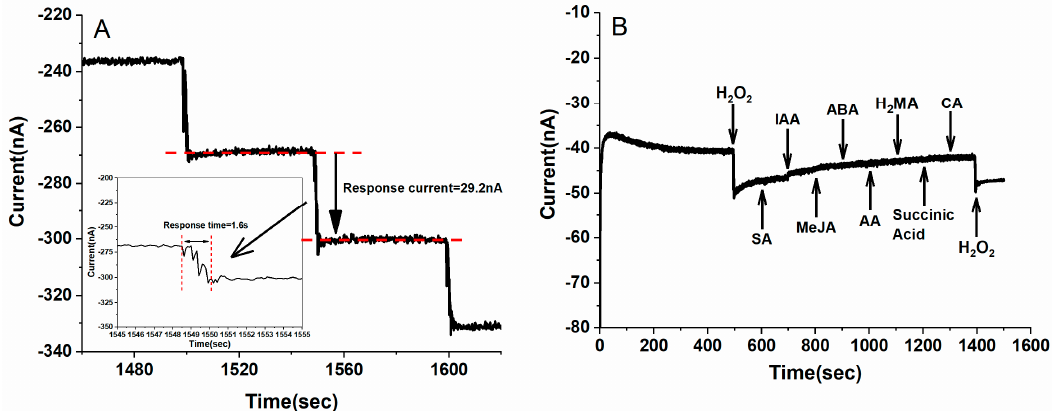
Figure 5. ( A ) Response time of the Au/SS wire-based electrochemical microsensor to the H 2 O 2 . Amperometric response to continuous additions of 10 µL H 2 O 2 with concentration 500 mM in 10 mL solution with 0.2 M PBS (pH 7) at − 0.6 V application potential. ( B ) The ant-interference ability of the SS wire-based electrochemical microsensor for detection of H 2 O 2 . Amperometric response to continuous additions of 10 µL H 2 O 2 , salicylic acid (SA), indole-3-acetic acid (IAA), methyl jasmonate (MeJA), abscisic acid (ABA), ascorbic acid (AA), malic acid (H 2 MA), succinic acid, and citric acid (CA), and H 2 O 2 with concentration 100 mM, respectively, in 10 mL solution with 0.2 M PBS (pH 7) at − 0.6 V application potential.